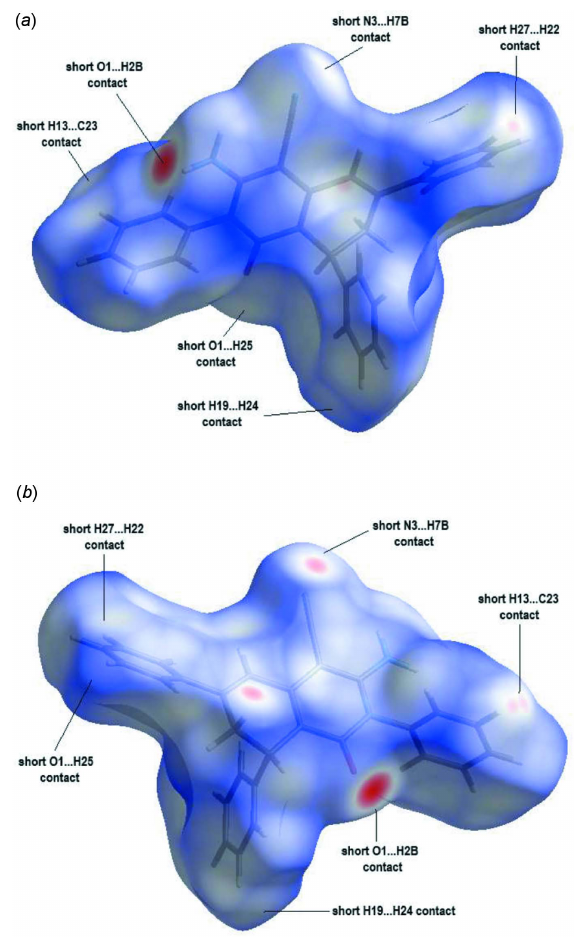
Figure 4 ( a ) Front and ( b ) back sides of the three-dimensional Hirshfeld surface of the title compound plotted over d norm in the range (cid:4) 0.4556 to 1.6207 a.u.